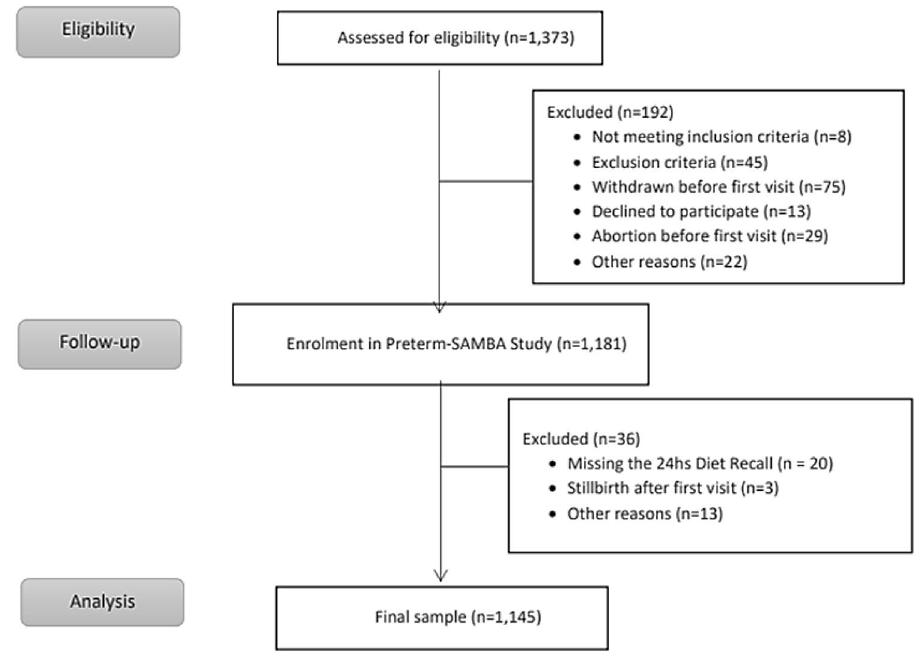
Figure 1. Flowchart of the sample (produced by MJ